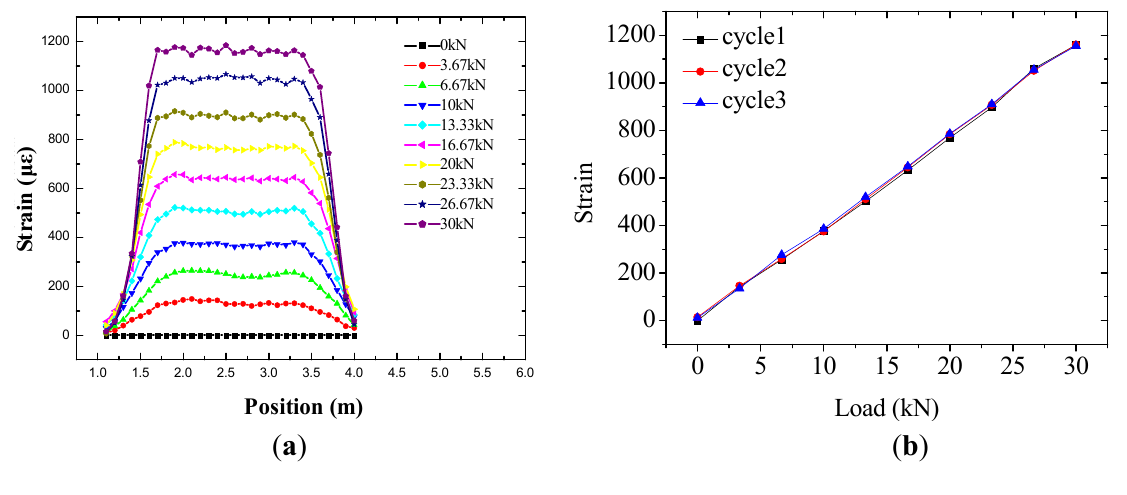
Figure 6. Results of the calibration test. ( a ) Strain distribution; ( b ) Relation between loads and strain at the position 2.5